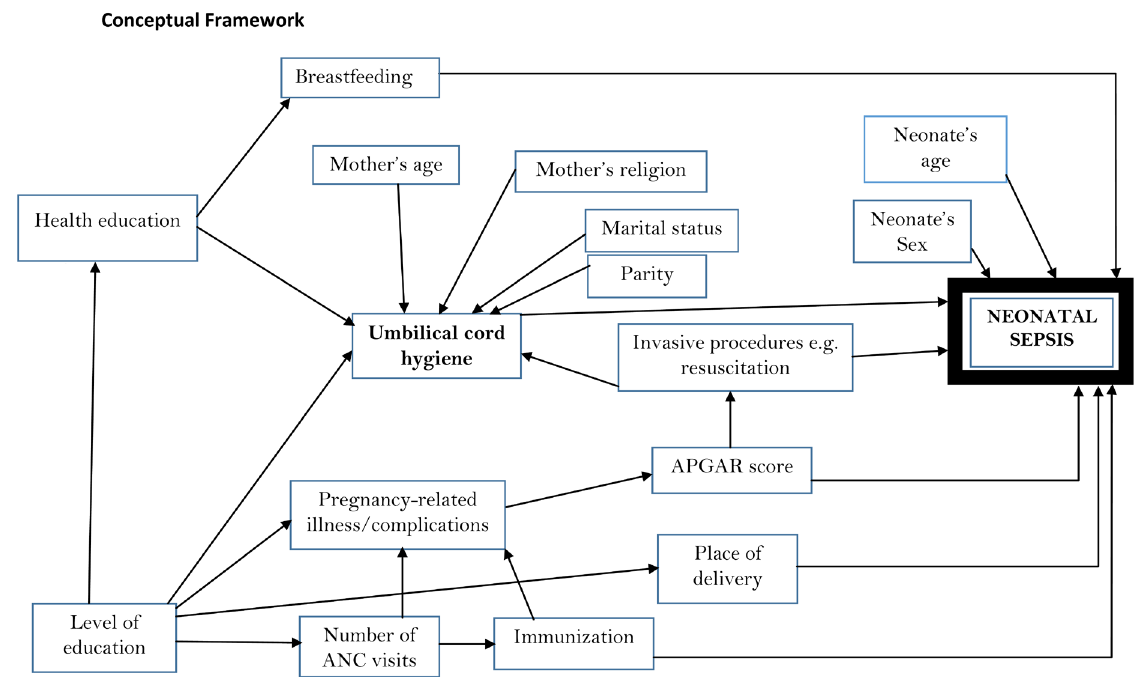
Figure 1. Causal diagram of umbilical cord hygiene and other factors thought to influence on neonatal sepsis occurrence among neonates at Kahawa Health Centre,